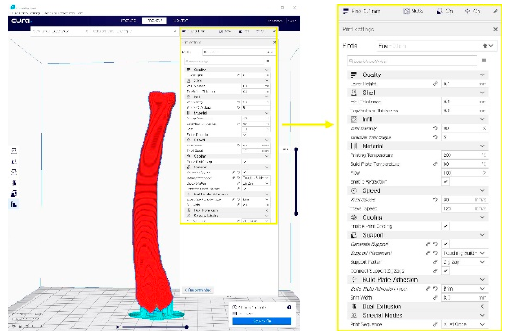
Figure 4. A G ‐ code file generating process for the 3 ‐ D printing process. It can be generated from the STL image using the CURA application program.